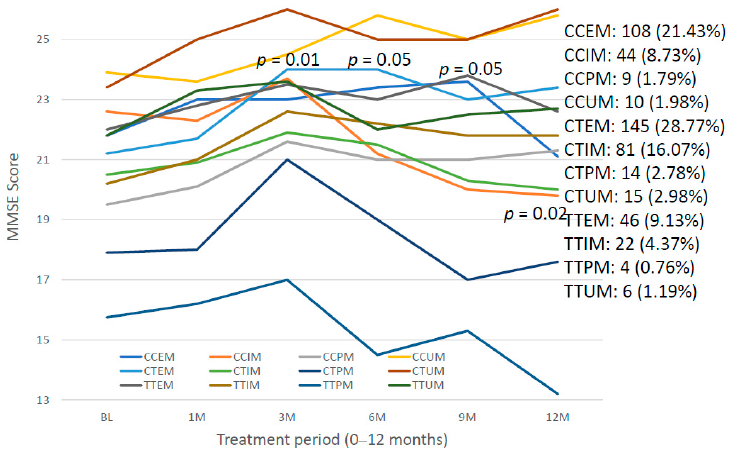
Figure 22. SIRT2-CYP2D6 GenoPhenotype-related therapeutic response to a multifactorial treatment in Alzheimer’s disease.